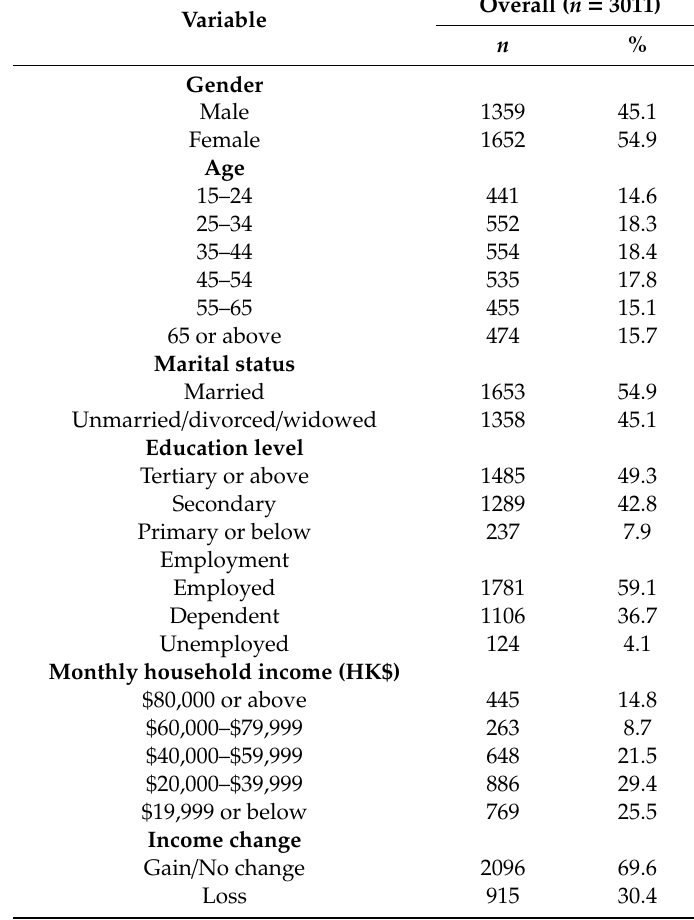
Table 1. Sociodemographic characteristics of the sample ( n = 3011) during February 25–April 29